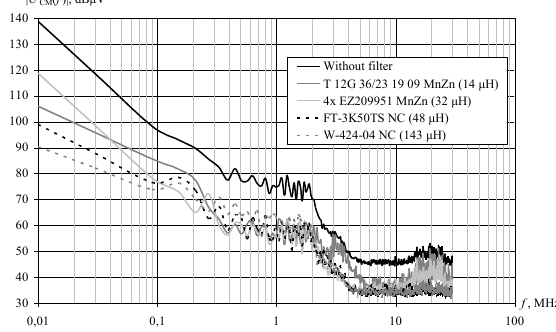
Fig. 4. Obtained CM EMI spectra generated by a frequency inverter without a filter and with a passive filters with various core materials .